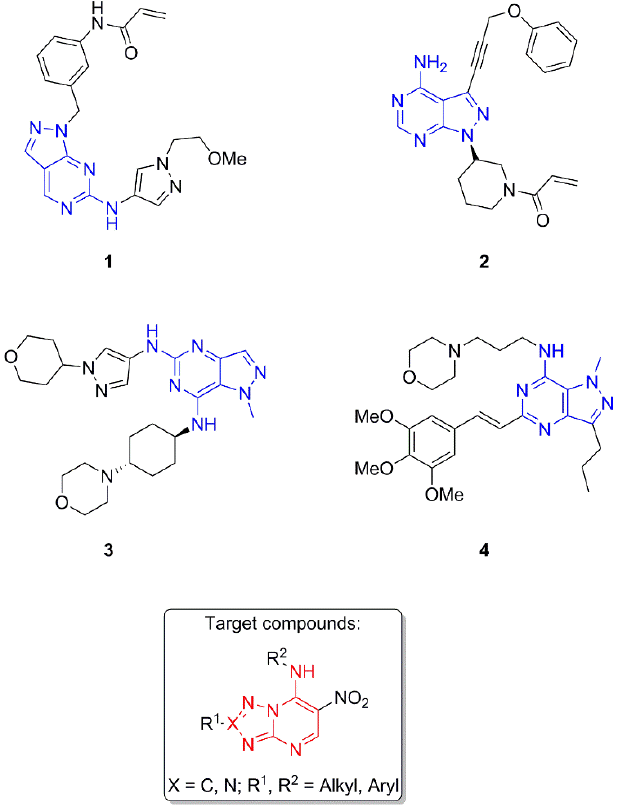
Figure 1. Previously reported pyrazolopyrimidines with anti-inflammatory properties and design of the target compounds.